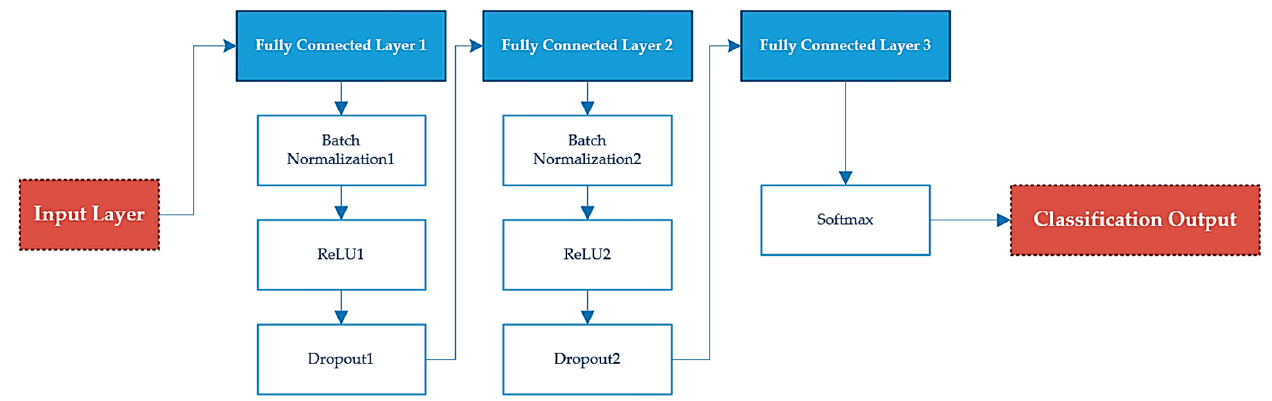
Figure 3. DNN Architecture.